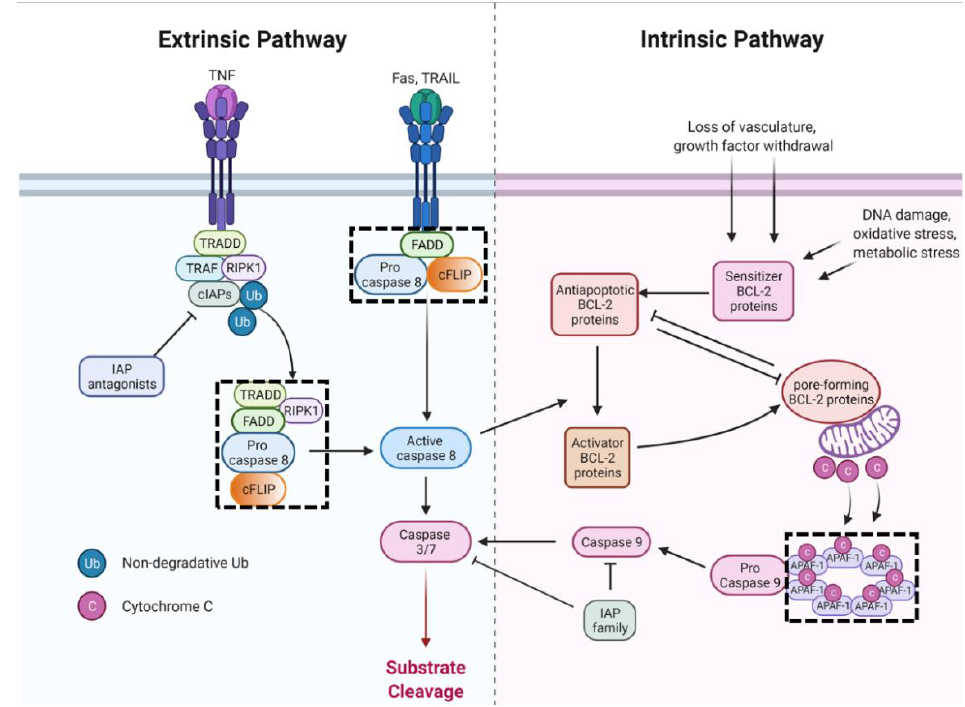
Figure 2. Apoptosis pathways. The dashed box denotes Supramolecular Organizing Centers (see Box 1). Abbreviations: TNF: tumor necrosis factor; TRAIL: TNF-related apoptosis-inducing ligand; TRADD: TNF receptor-associated death domain protein; TRAF: TNF receptor-associated factor; FADD: Fas-associated death domain protein; RIPK1: receptor interacting serine threonine kinase 1; cFLIP: cellular FLICE-like inhibitory protein; APAF-1: apoptotic protease-activating factor 1; IAP: inhibitor of apoptosis protein family. Adapted from “Extrinsic and Intrinsic Apoptosis”,